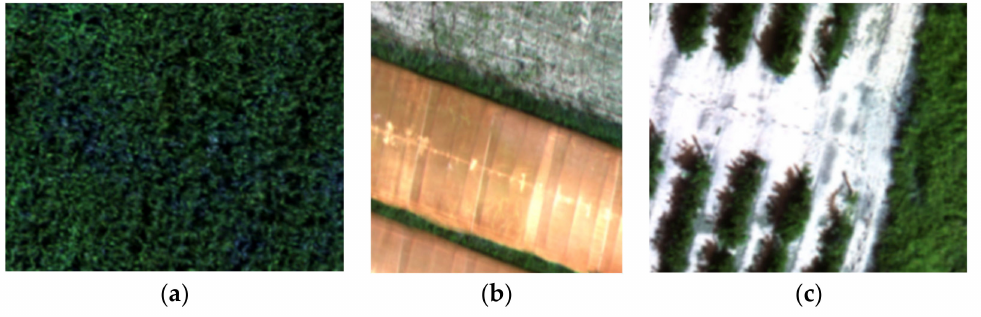
Figure 6. Sample characteristics under RGB color model. ( a ) Corn. ( b ) Greenhouse. ( c ) Grapes.